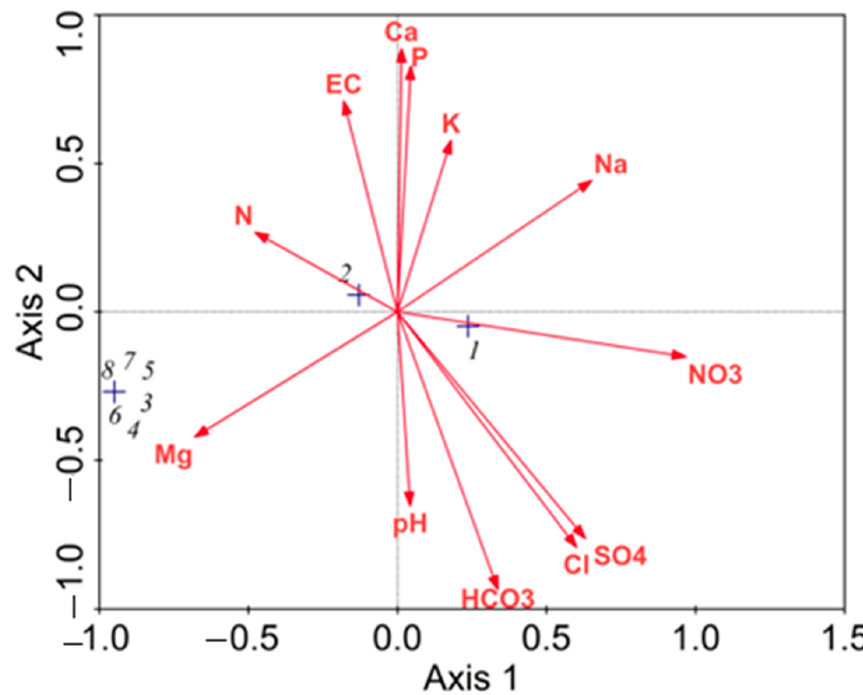
Figure 2. CCA biplot with the soil characteristics ( → ) and parameters (+) of Taif rose. 1: height (cm); 2: diameter (cm); 3: leaf biomass (kg ind. − 1 ); 4: stem biomass (kg ind. − 1 ); 5: above-ground biomass (kg ind. − 1 ); 6: leaf biomass (t ha − 1 ); 7: stem biomass (t ha − 1 ); 8: above-ground biomass (t ha − 1 ). Table 2. Inter-set correlations of the soil characteristics with CCA